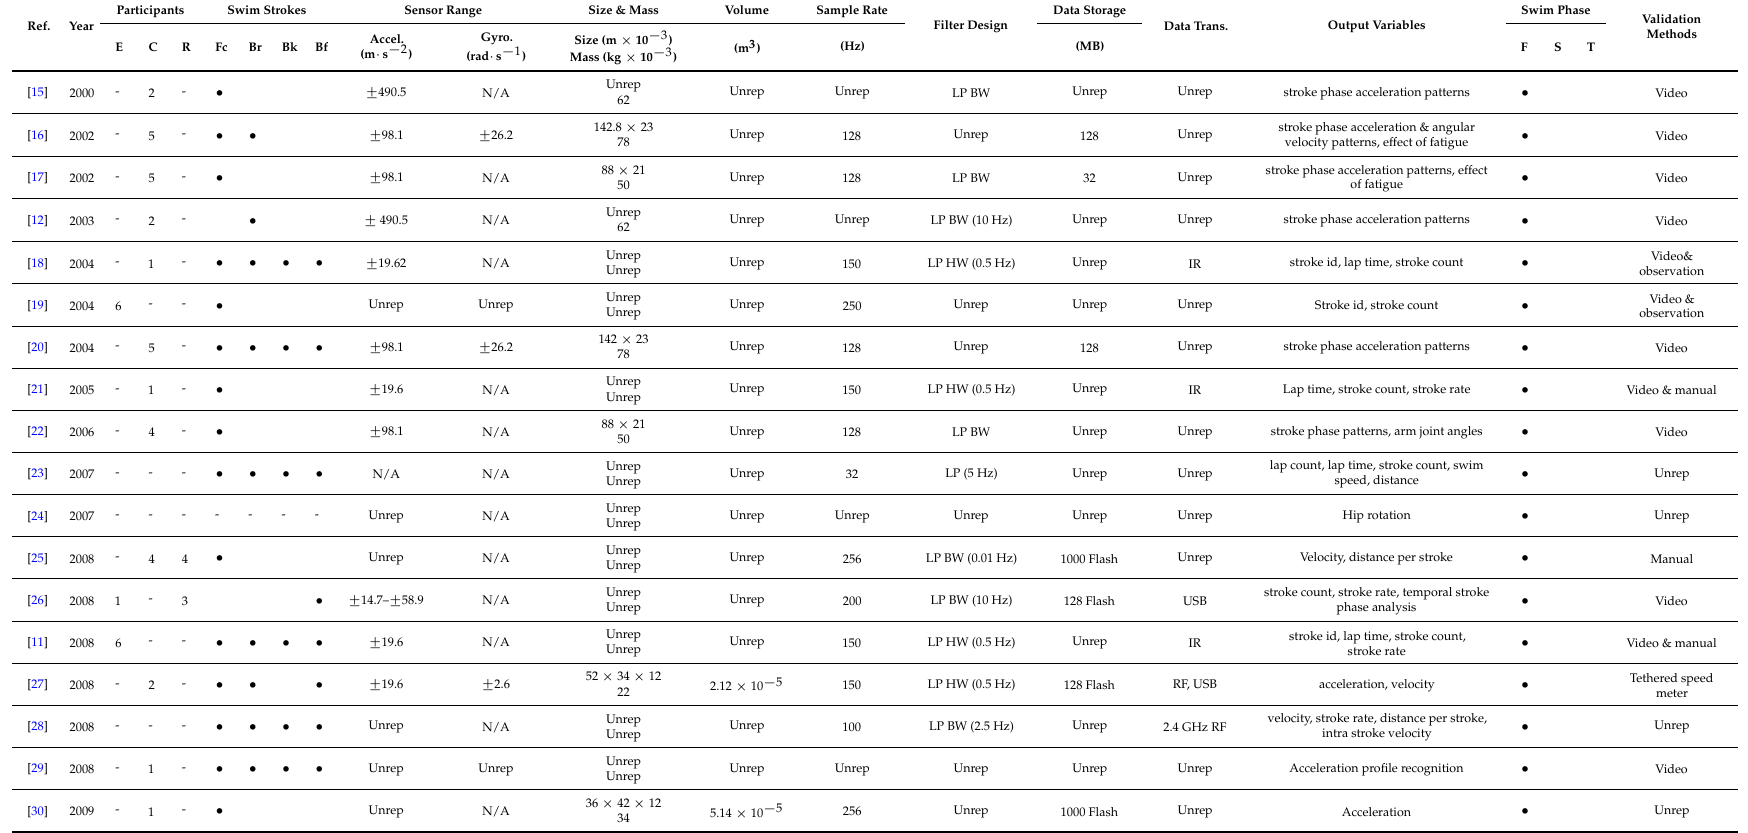
Table 1. Summary of selected research studies investigating the use of inertial sensor technology for swimming analysis. References are presented in chronological order. Details included relate to the number of participants involved and their status (E: elite, C: competitive, R: recreational), swimming strokes examined (Fc: frontcrawl; Br: breaststroke, Bk: backstroke, Bf: butterfly); accelerometer and gyroscope sensor ranges; device size and mass; volume (where three dimensions are reported); sampling rate; filter design (LP: Low Pass, BW: Butterworth, HW: Hamming window, MA: Moving average); data storage; data transmission (RF: radio-frequency, IR: infra-red); output variables reported for different phases of swimming (F: free-swimming; S: starts; T: turns) and validation procedures. (Unrep =